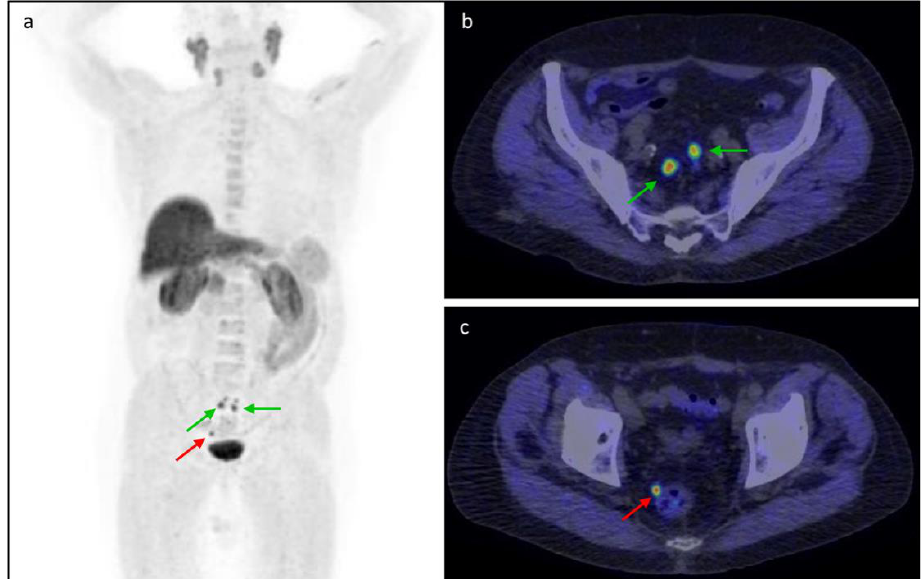
with SUVmax 5.2 (red arrow).